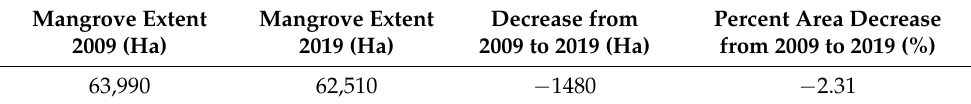
Table 1. Mangrove forest extent derived from Random Forest classification with Landsat NDVI images 2009 and 2019 (Bowen to Shoalwater and Corio Bays Area Ramsar Wetland, Central Queensland).